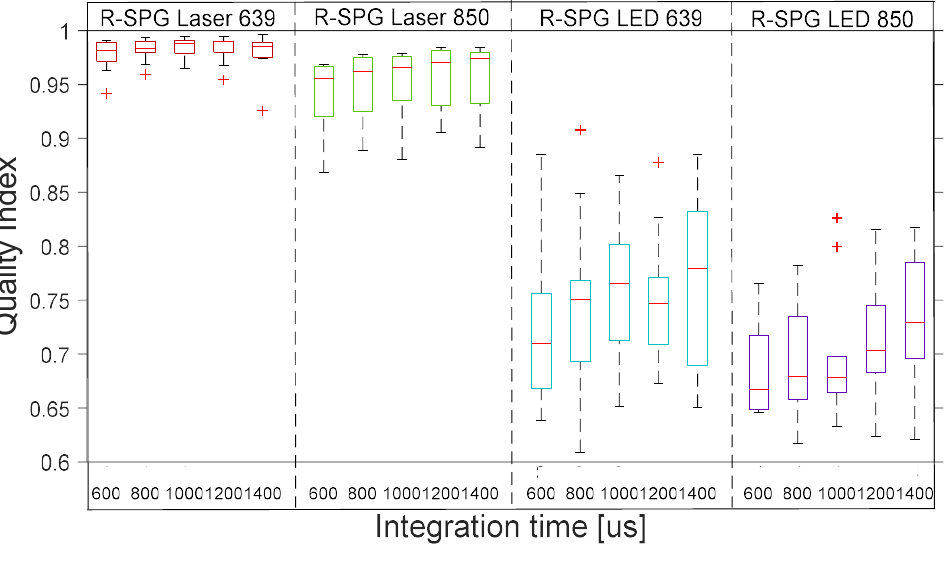
Figure 7. Reflective mode boxplots of quality index for R-rSPG signals with 4 different lights at 5 integration times in the reflection. The inner box divisions indicate: Q1 (the first quartile) to Q3 (the third quartile). The median is marked by a line across the box. The “whiskers” indicate results from Q1 and Q3 to the most extreme data points. The + symbols represent outliers.